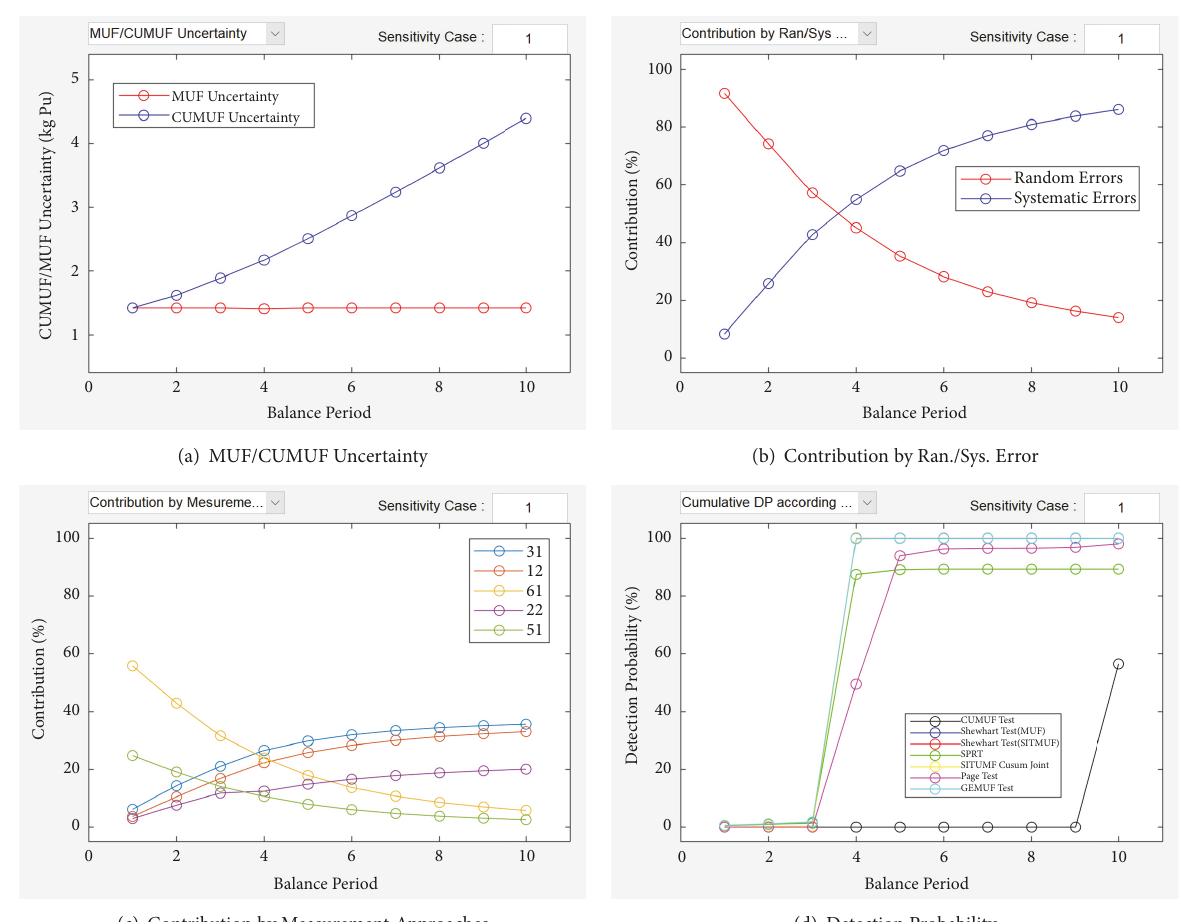
Figure 5: Graphs provided by PYMUS+